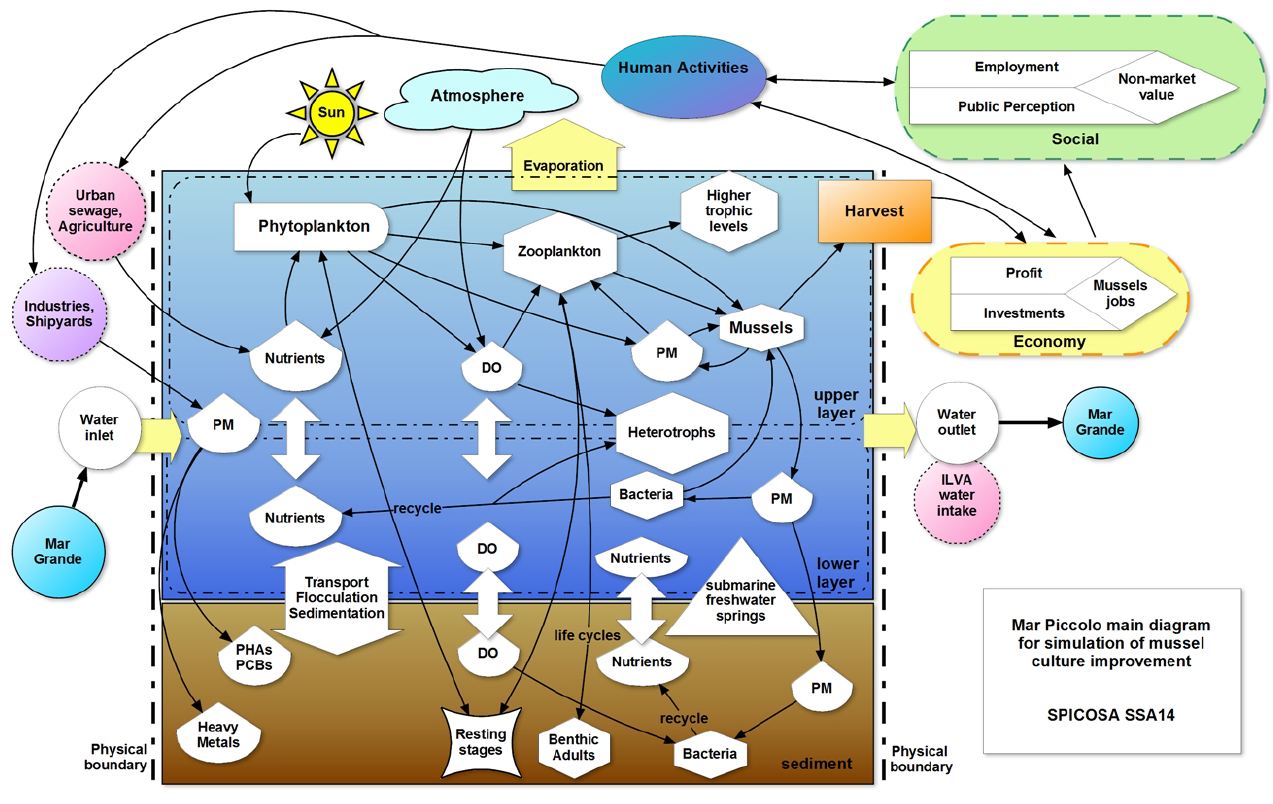
Fig. 3 . Conceptual diagram of the ecological component of the simulation model showing inputs and key interactions among the main functional components and processes. The environmental compartments considered are the upper and lower water column layers and the bottom sediments.